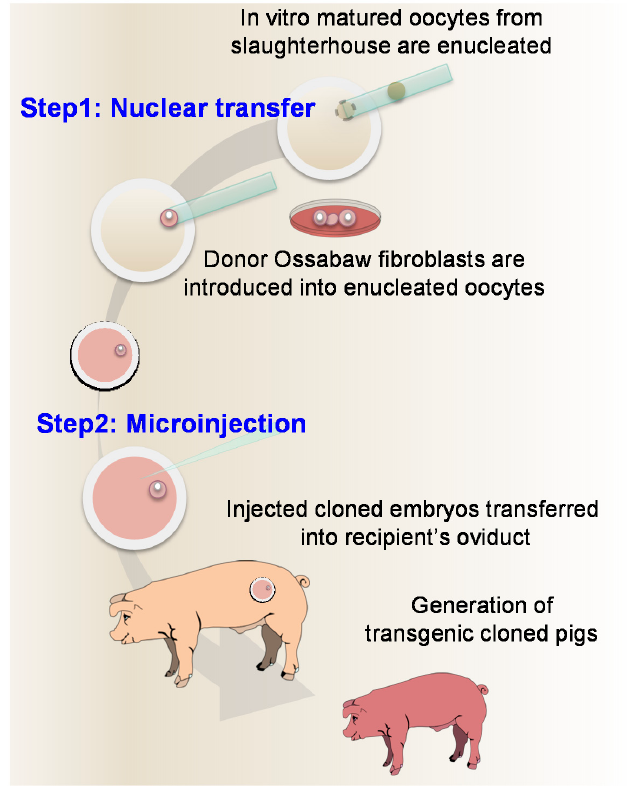
Figure 1. Schematic outlining the strategy for editing cloned zygotes.